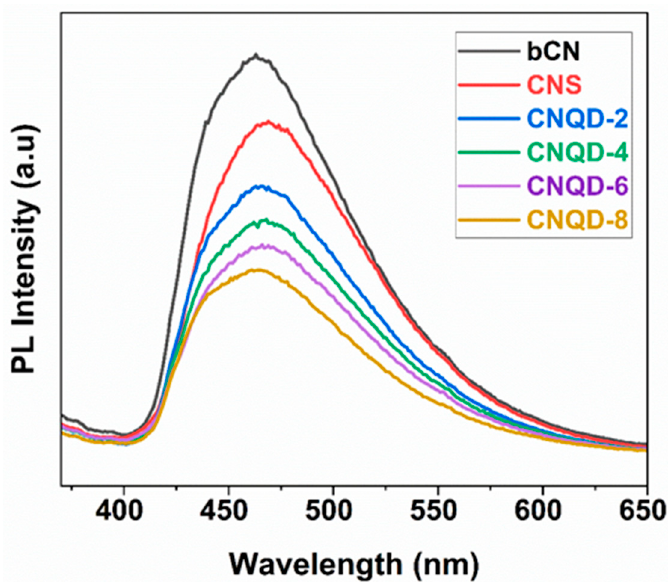
Figure 10. PL spectra of bCN, CNS, and CNQD photocatalysts.